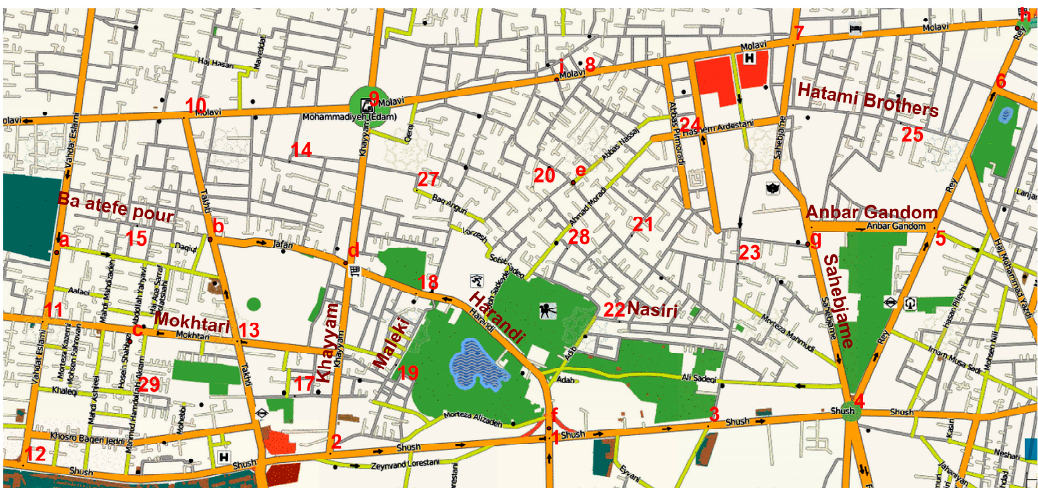
Figure 8. Study area with numbered points presented to the panellists to assess permeability and legibility.